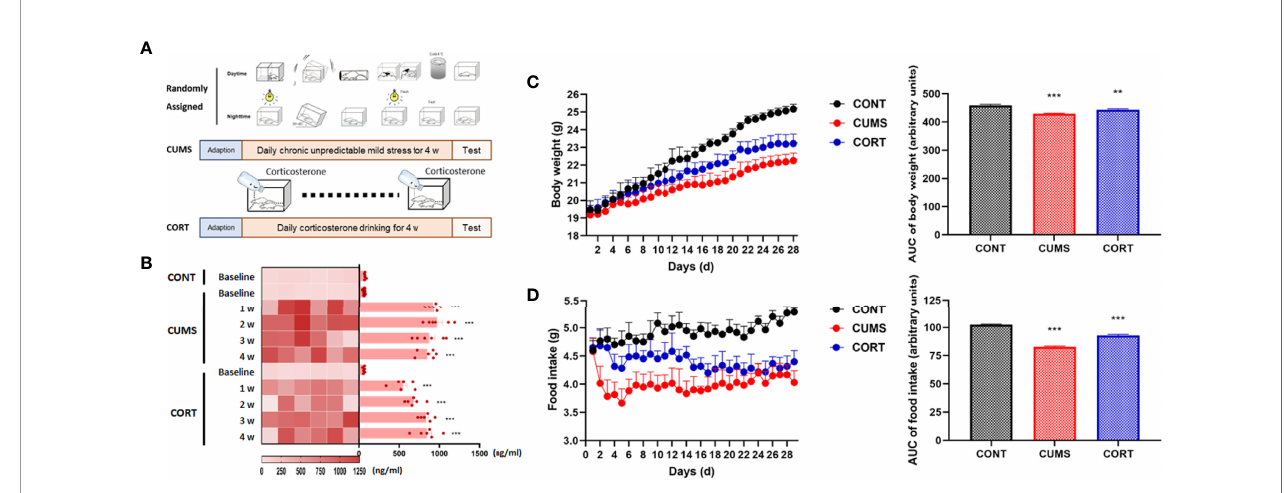
FIGURE 1 | Mice with chronic stress exhibited negative effects on daily weight gain and stress. (A) Mice in chronic stress received CUMS or CORT drinking for 4 weeks. (B) Serum CORT level was measured at baseline, 1, 2, 3, and 4 weeks after receiving chronic stress (repeated measurement ANOVA with Tukey ’ s post hoc test, *** P < 0.001, compared with baseline; n = 6). (C) Daily body weight was recorded and area under the time-course curve (AUC) was analyzed (two-way ANOVA with Tukey ’ s post hoc test, ** P < 0.01, *** P < 0.001, compared with CONT; n = 12). (D) Daily food intake was recorded and AUC was analyzed (two-way ANOVA with Tukey ’ s post hoc test, *** P < 0.001, compared with CONT; n =